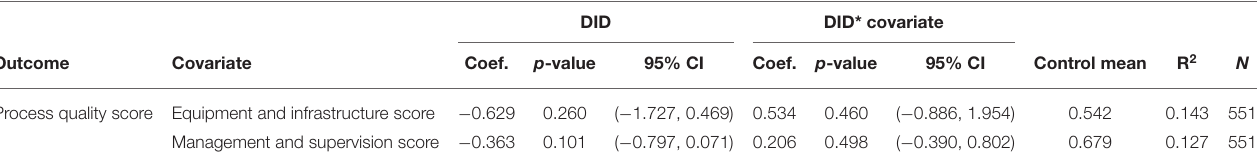
TABLE 14 | Interaction between process and structural ANC quality.